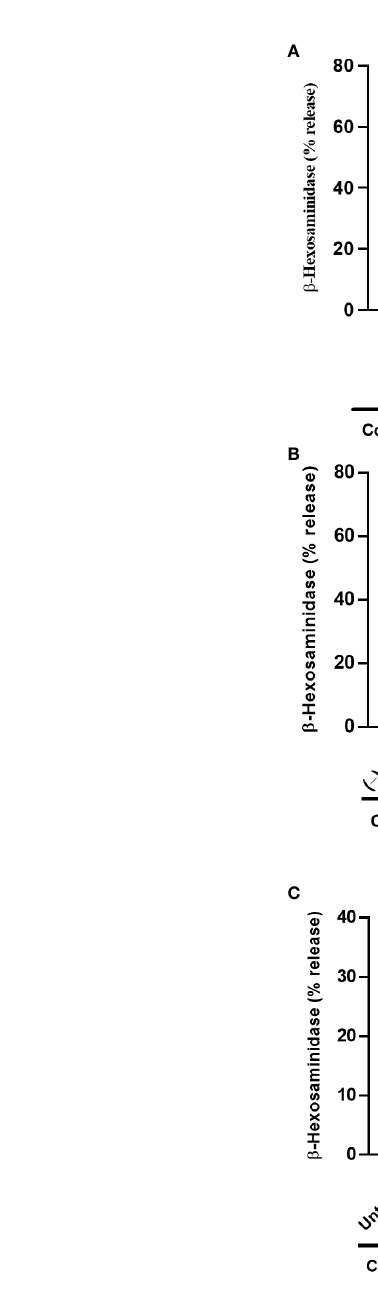
FIGURE 8 C9 does not inhibit MrgprB2-mediated degranulation in mouse peritoneal MCs. (A) Wild type (WT) and MrgprB2 − / − peritoneal-derived MCs (PMCs) were exposed to SP (100 µM), PAMP-12 (10 µM), and rocuronium (20 µg/ml) for 30 min and b -hexosaminidase release was measured. (B) WT-PMCs were cultured in the absence or presence of PTx (100 ng/mL, 16 h), exposed to SP, PAMP-12, or rocuronium for 30 min, and b